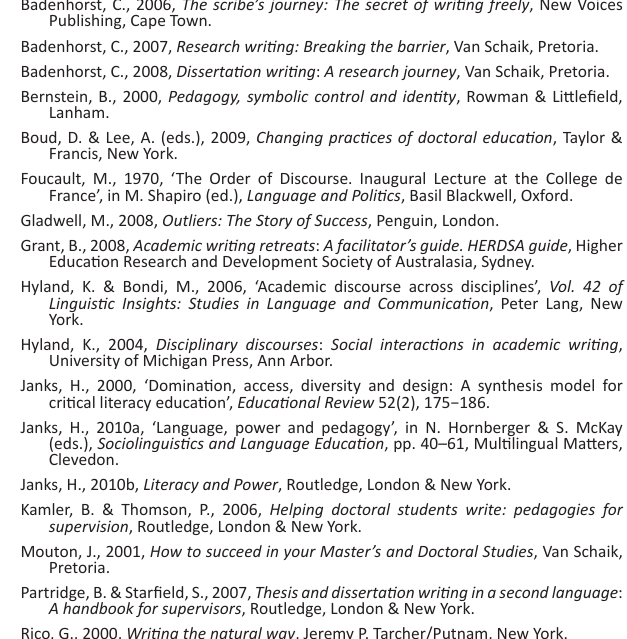
FIGURE 9: Rough work 2.